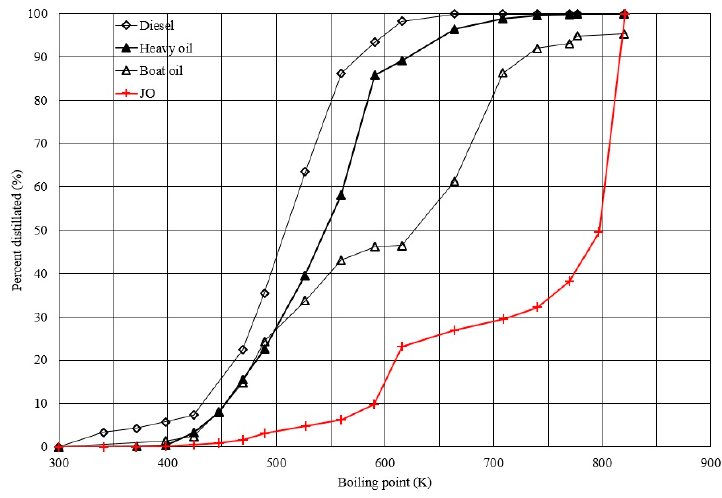
Figure 1. Simulated distillation characteristics of jatropha oil (JO), diesel, heavy oil and boat oil.